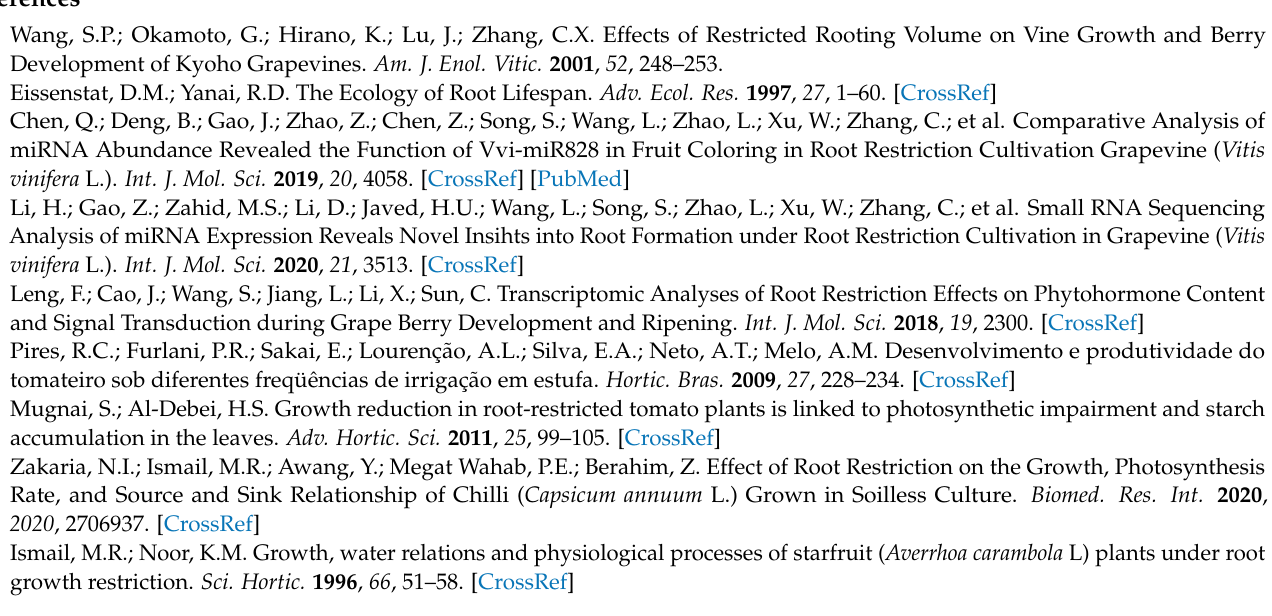
Table S3. Sequences of primers used for real-time